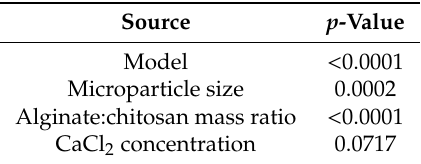
Table 3. p -values of ANOVA for Box–Behnken model.